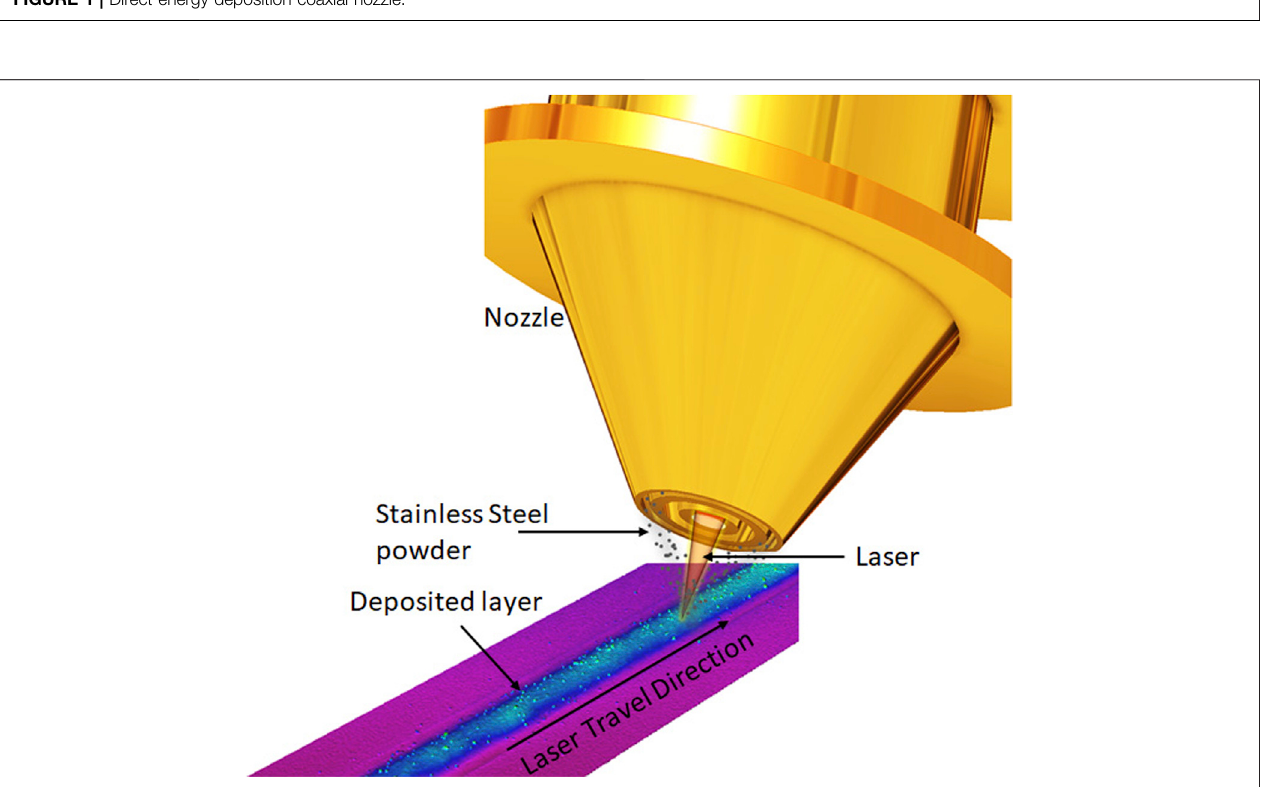
FIGURE 2 | Schematic of direct energy deposition.